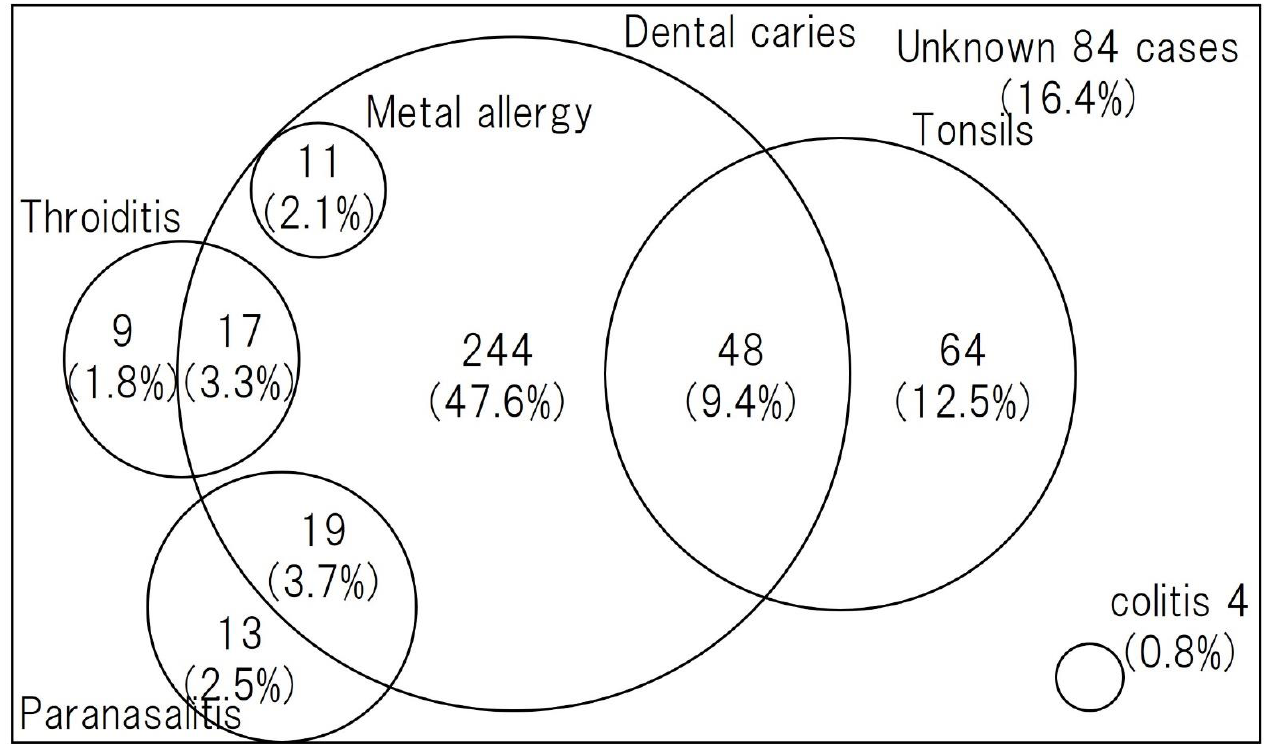
Figure 1. Comorbidity, including focal infection in PPP [25]. Dental caries was the most common focal infection, followed by tonsillitis and